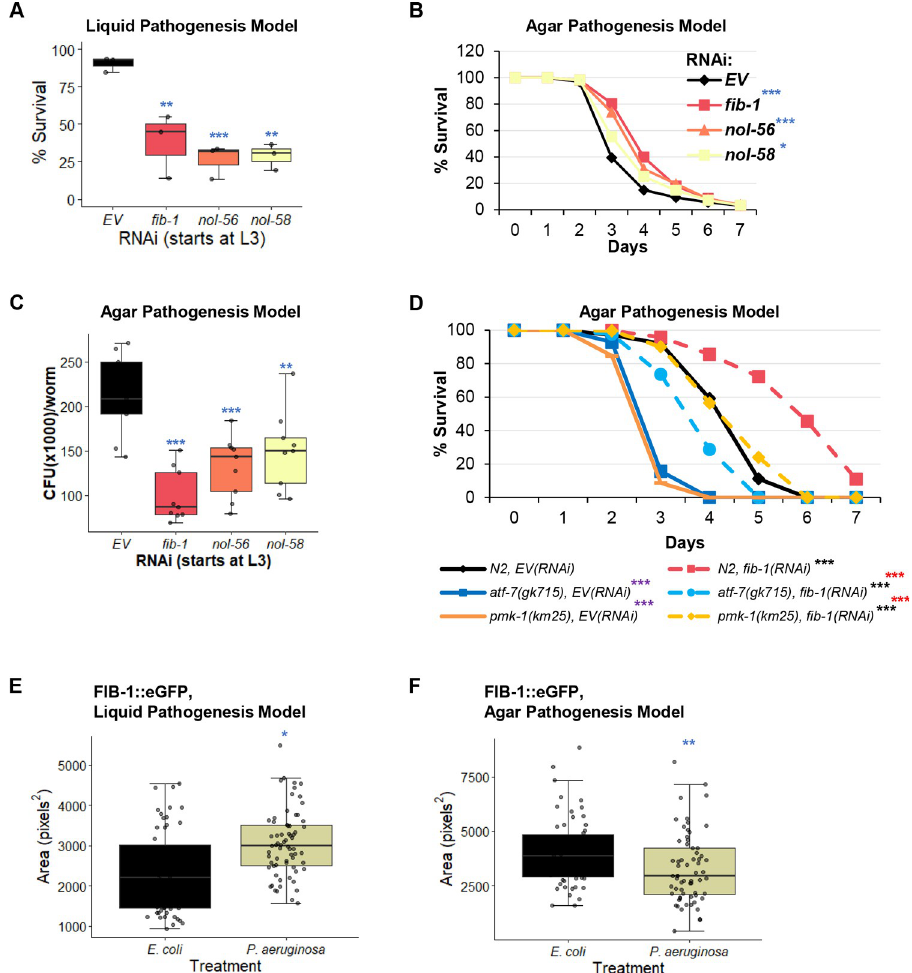
Fig 8. Box C/D snoRNP disruption has context-specific effects on P . aeruginosa pathogenesis. (A, B) Survival of glp-4(bn2) worms grown on box C/D(RNAi) (A) Liquid Killing (LK, liquid pathogenesis model) and (B) Slow killing (SK, agar pathogenesis model) assays. (C) Quantification of colony forming units (CFU) within the intestine of glp-4 (bn2) worms grown on box C/D(RNAi) 48 hours post infection with P . aeruginosa in the SK assay. (D) Survival of N2 wild-type, atf-7(gk715) , or pmk-1(km25) mutant worms reared on empty vector ( EV ) or fib-1(RNAi) . (E, F) Quantification of fluorescence of worms carrying a Pfib-1 ::FIB-1::eGFP reporter 10 hours after exposure to P . aeruginosa in Liquid Killing (LK, (E) ) or Slow Killing (SK, (F) ) pathogenesis models. Three biological replicates with ~400 (LK), ~150 worms/replicate (SK), or ~60 (CFU assay and FIB-1::eGFP imaging) worms/replicate were analyzed. Representative replicates are shown for the SK assays. p -values were determined from one-way ANOVA, followed by Dunnett’s test for LK or CFU assay, log-rank test for SK, or Student’s t -test for FIB-1::eGFP imaging data. � p < 0.05, �� p < 0.01, ��� p < 0.001. (D) Purple significance marks indicate comparison between atf-7(gk715) or pmk-1(km25) mutants and wild-type (N2) worms reared on empty vector RNAi ( EV ), red marks indicate comparison between atf-7 (gk715) and pmk-1(km25) mutants to wild-type (N2) worms reared on fib-1(RNAi) , and black marks indicate comparison between fib-1(RNAi) and EV(RNAi) for each worm